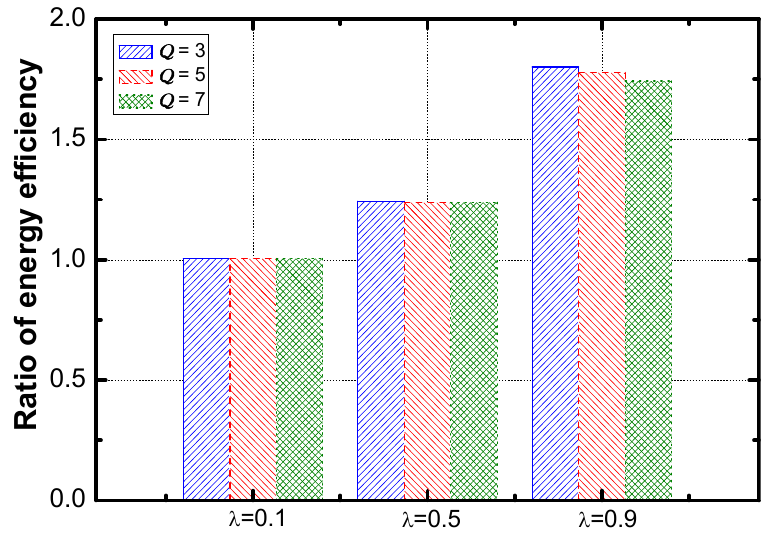
Figure 22. The ratio of energy efficiency vs. λ .